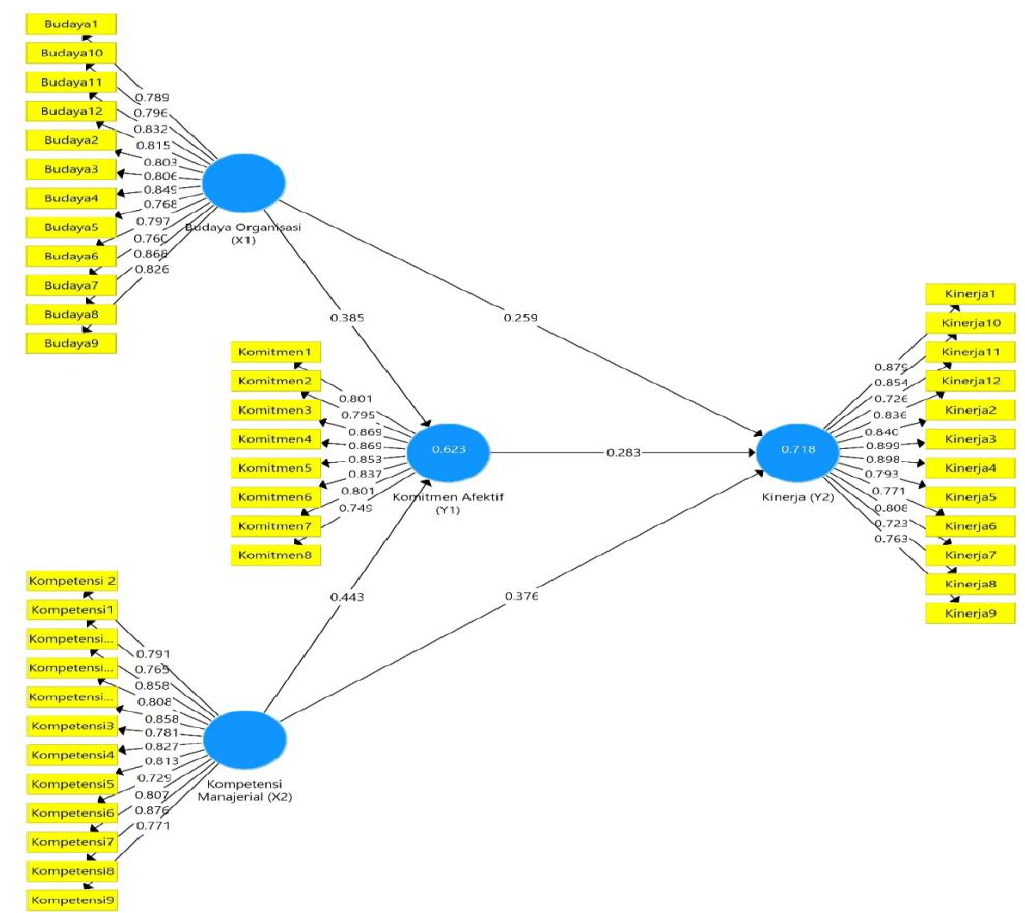
Figure 1: PLS Structural Model; Source: Output SmartPLS version 3.3.3